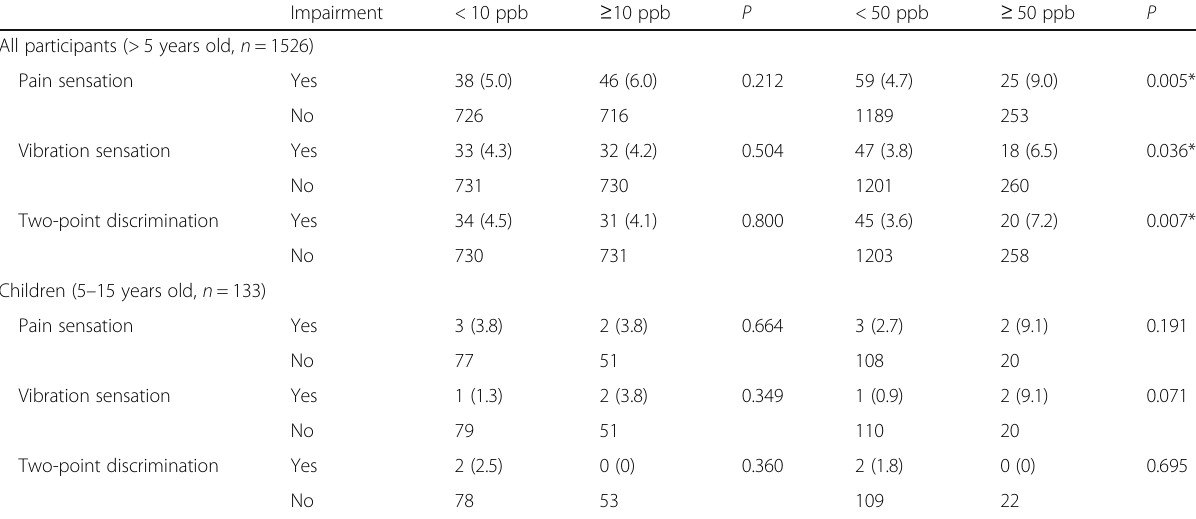
Numbers indicate the number of participants Numbers in parentheses indicate the percentage of “ yes ” participants in each ACDW group Statistical analyses were performed using the chi-square test. * P <0.05, ** P <0.01, statistically significant difference Yes = present; no =